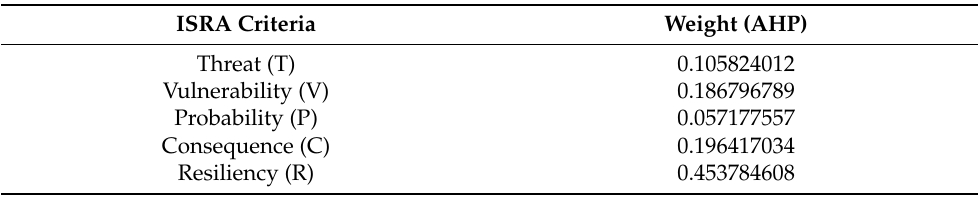
Table 2. Weights of generic ISRA criteria obtained by the AHP.